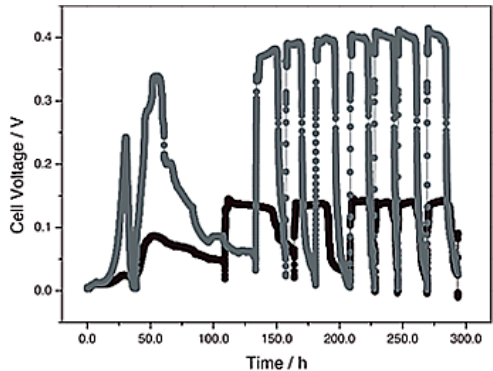
Figure 2. Voltage generation curve for MFCs operated with polyaniline (PANI) nano fi bers ( ● ) and PANI nanofibers/CB composite ( ● ) cathodes. (Figure 4B from [72]. Reproduced by permission of The Electrochemical Society).